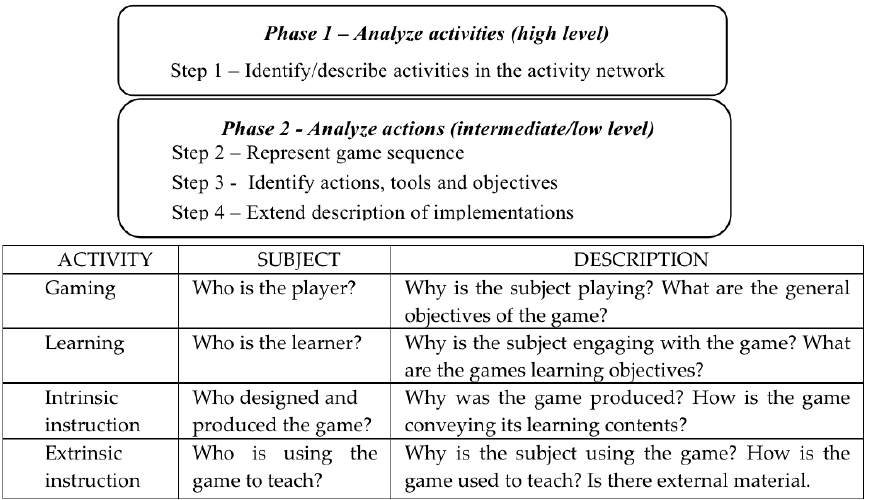
Fig. 1. Four-step approach for applying ATMSG